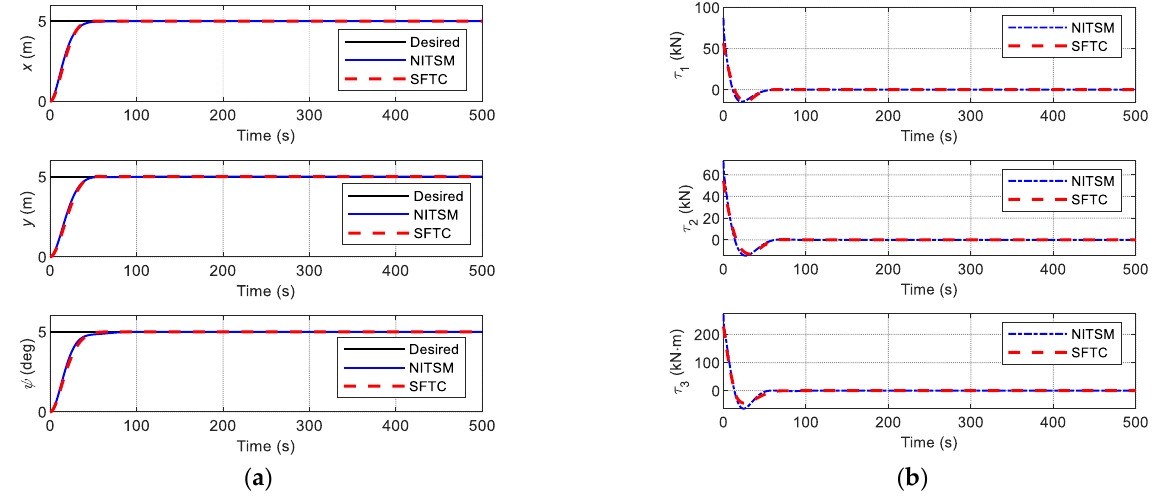
Figure 8. Comparison of simulation results. ( a ) Position ( x , y ) and heading ψ , ( b ) control puts.